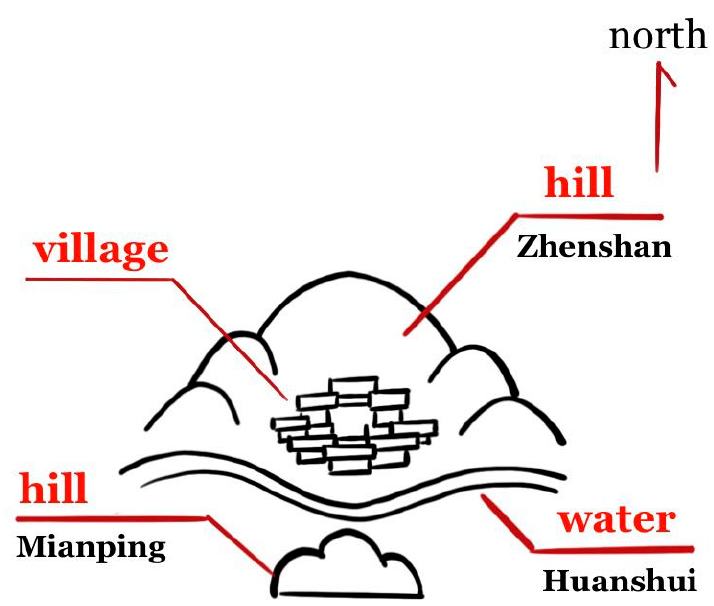
Figure 1. Ideal siting pattern for villages. Source: [11].